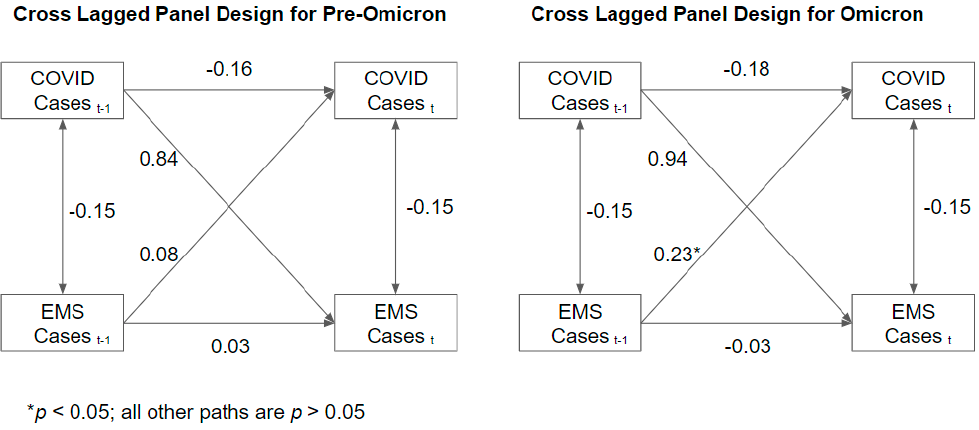
Figure 2. Association between ambulance calls and positive COVID-19 tests with (t − 1) and without (t) a one-week time lag.